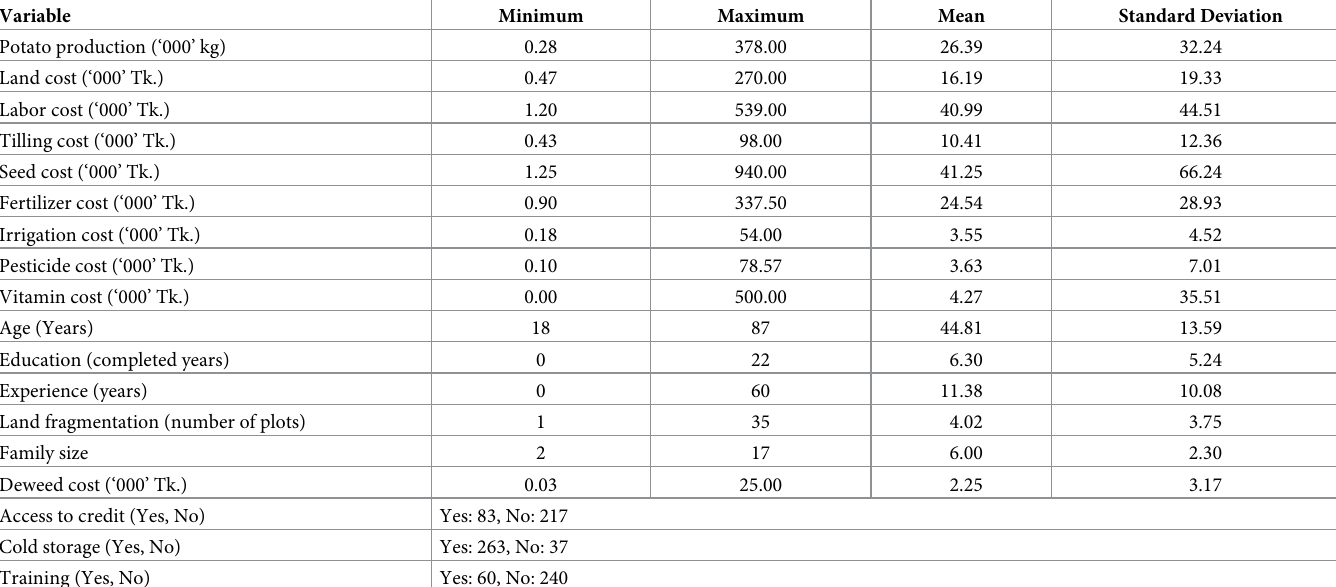
Table 1. Summary statistics of variables used in this